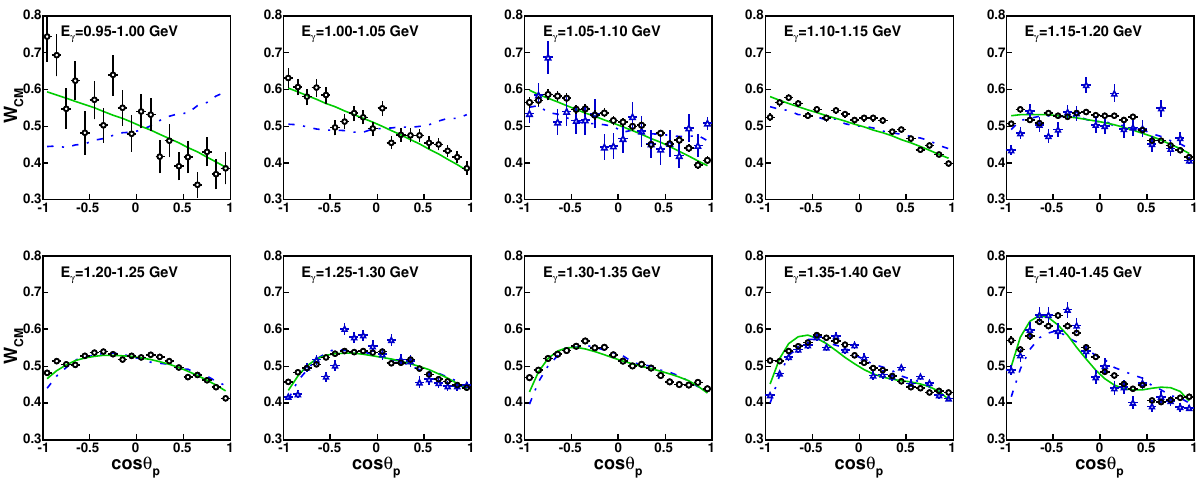
Figure 6. The same notation as for Fig. 5, but the angular distributions for the proton are shown. Figure taken from Ref.